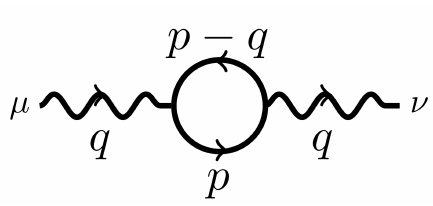
Figure 10: Feynman diagram for the 2D polarization tensor Π µν ( q )